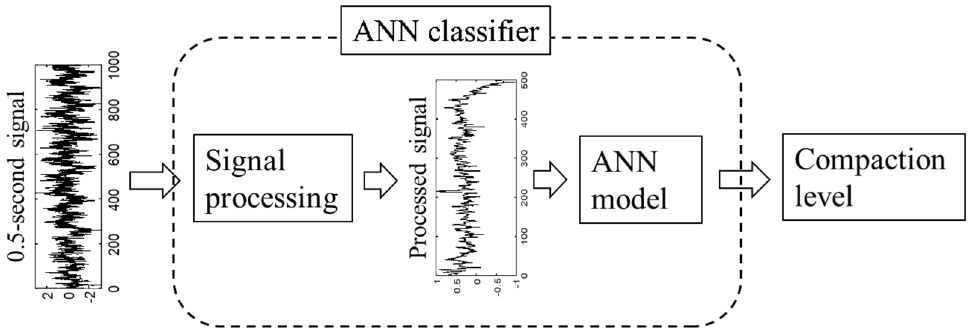
Figure 10. ANN classifier.